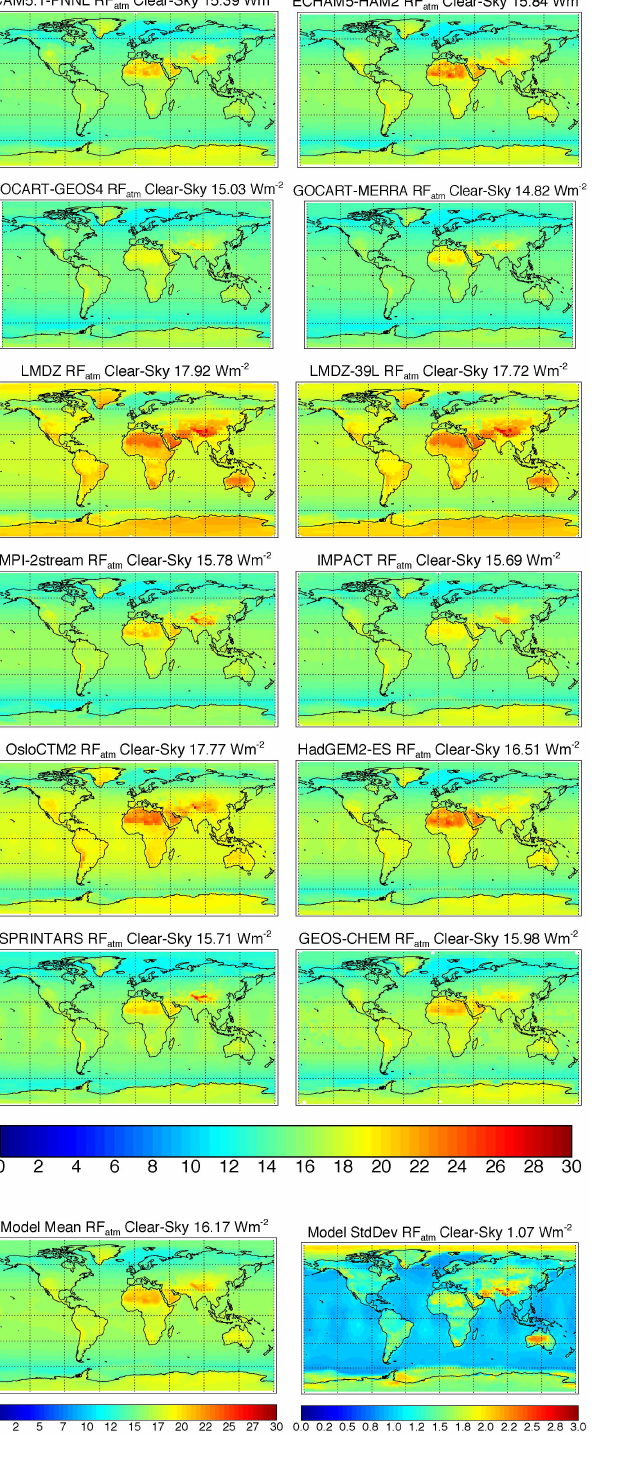
Fig. 10. Annual mean short-wave clear-sky atmospheric radia- tive forcing (absorption) between experiments with AOD=0.2 and AOD=0.0 distributed over the lowest two kilometers, holding SSA=0.8 and ANG=1.0 constant (FIX3-FIX0).